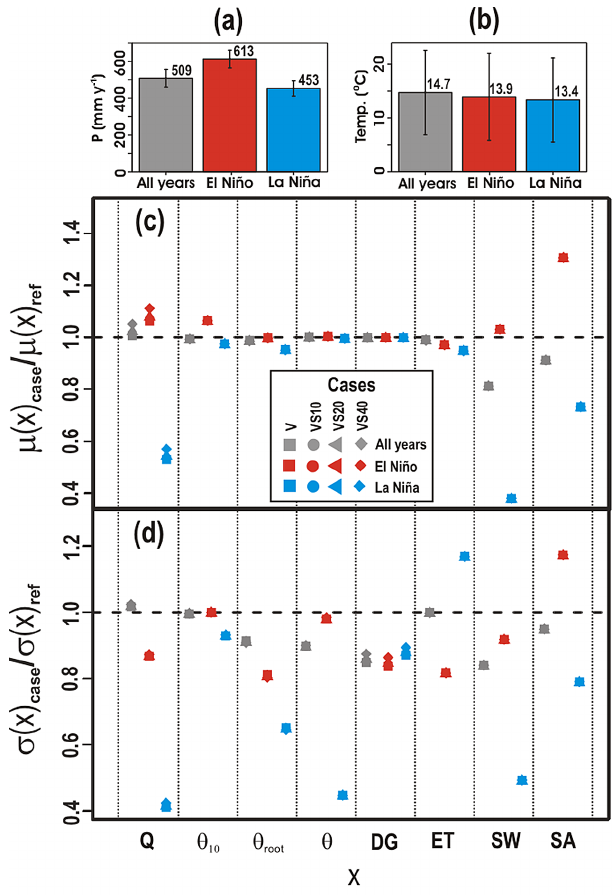
Figure 10. Mean multi-annual (a) precipitation and (b) air temper- ature values at Tonto Creek during the 1990–2010 period (grey), El Niño (red) and La Niña (blue) years. Standard deviation bars have been added to each variable. ENSO phases follow the anoma- lies in the Oceanic Niño Index from the NOAA National Predic- tion Center at http://wwww.cpc.ncep.noaa.gov/products/analysis_ monitoring/ensostuff/ensoyears.html. (c) Mean µ(X) case /µ(X) ref and (d) standard deviation σ(X) case /σ(X) ref ratios between forest thinning simulated scenarios (V, VS10, VS20, VS40) and the ref- erence case (represented by the dashed black lines) for all (grey), El Niño (red) and La Niña (blue) years for eight basin-scale hy- drologic variables (X on the x axis) that include outlet streamflow ( Q ), 10cm depth, root and vadose zone soil moisture ( θ 10 , θ root , θ ), depth to groundwater table (DG), evapotranspiration (ET), snow water equivalent (SW) and snow covered area (SA) mean basin val-